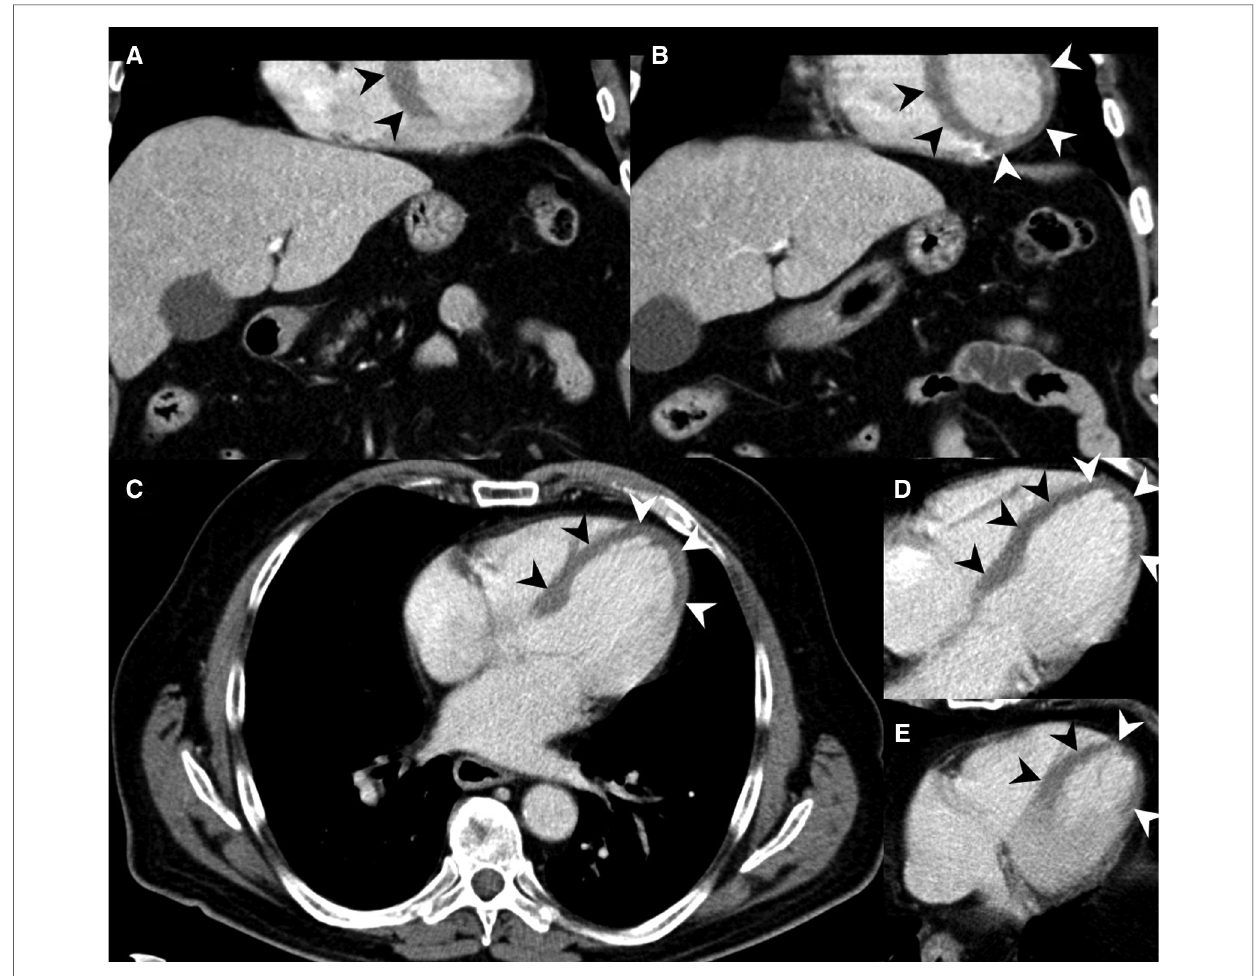
FIGURE 5 73-year-old male with acute MI, evident as MH on MDCT (arrowheads). ( A , B ) Coronal reformations show large areas of MH in the left ventricle. ( C – E ) MH shown at the interventricular septum and the heart apex in axial slices. The patient deceased after